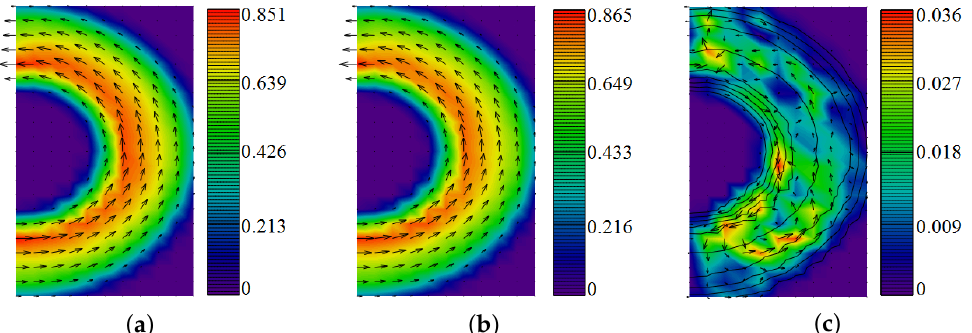
Figure 3. Numerical solution of the water flow between two coaxial cylinders problem: ( a ) based on the difference scheme (15); ( b ) based on the difference schemes (19)–(22); ( c ) the difference of the